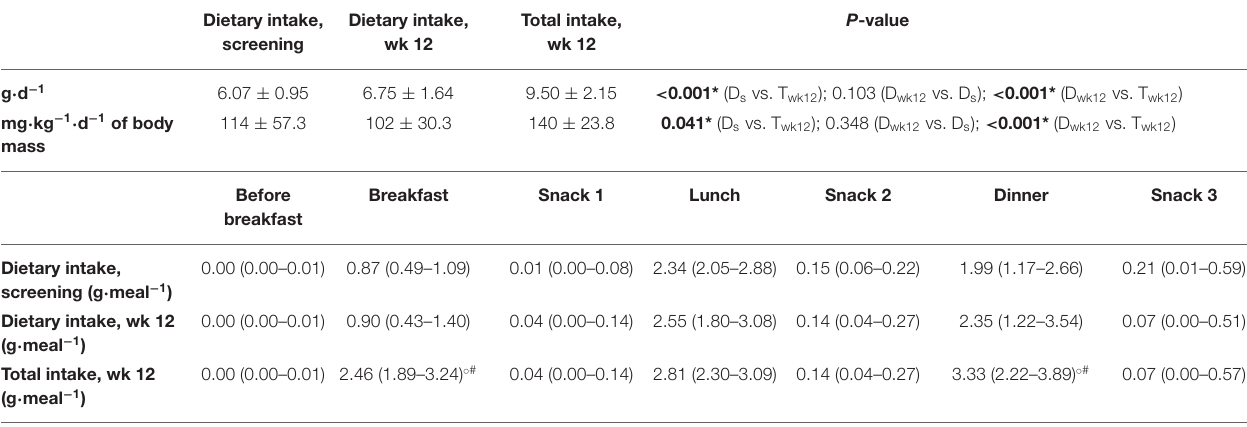
TABLE 4 | Leucine intake (g · d − 1 ) or (mg · kg − 1 · d − 1 of body mass) mean ± SD and distribution of leucine intake (median and interquartile range) of a subgroup of 20 community-dwelling (pre)sarcopenic older adults receiving protein supplement ( n = 20).